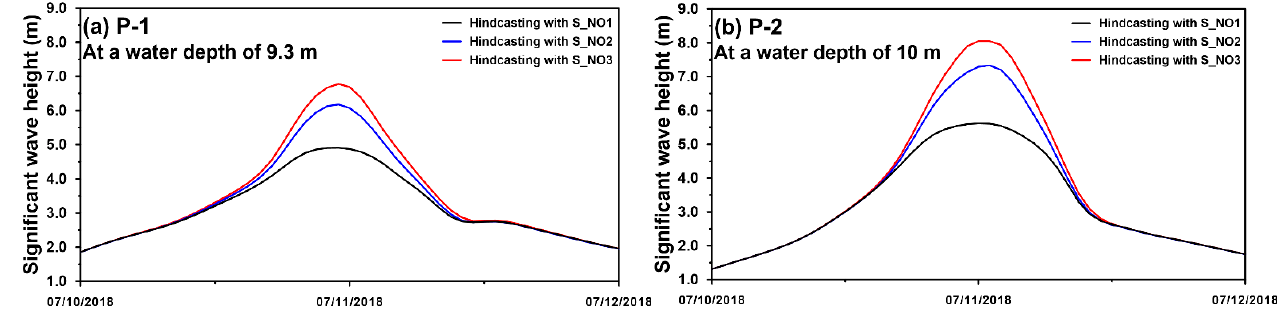
Figure 10. Time series of hindcasted SWHs for ( a ) P1 and ( b ) P2 using the S_NO1, S_NO2 and S_NO3 scenarios during the passage of Super Typhoon Maria in 2018.